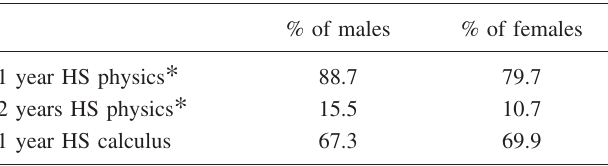
TABLE V. Percentages of males and females that have taken high school courses in calculus and physics. The asterisk (cid:1) * (cid:2) indi- cates that the difference in percentages is significant via (cid:4) 2 test; p (cid:3)